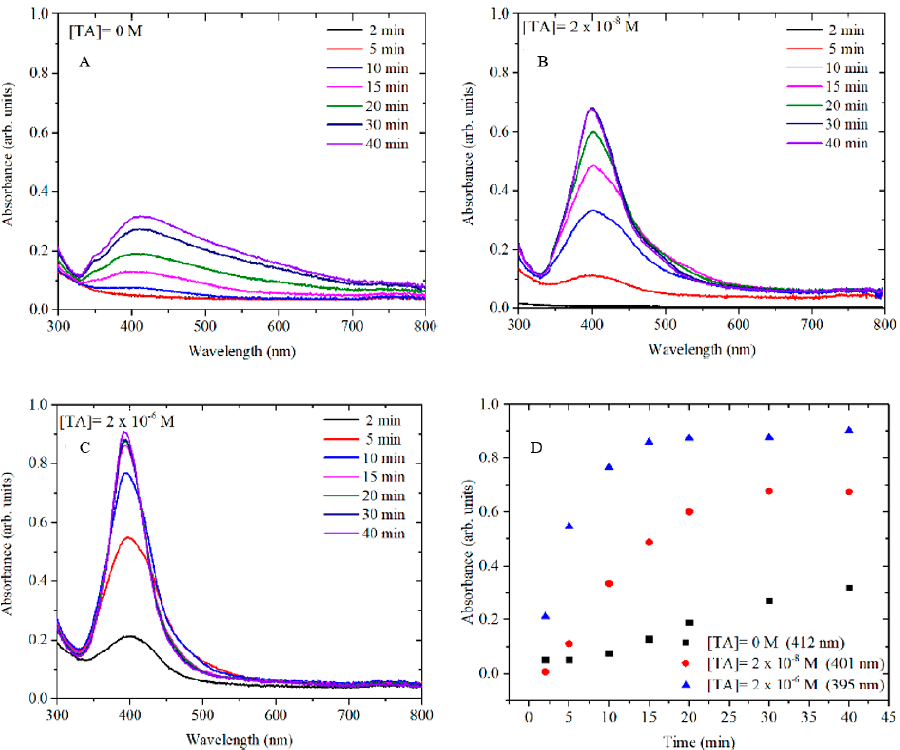
Figure 3. UV-vis spectra show the kinetics of AgNP growth by varying the concentration of TA: ( A ) 0 M, ( B ) 2 × 10 − 8 M, ( C ) 2 × 10 − 6 M and ( D ) plot of the kinetics at maximum adsorption for the three concentrations of TA.